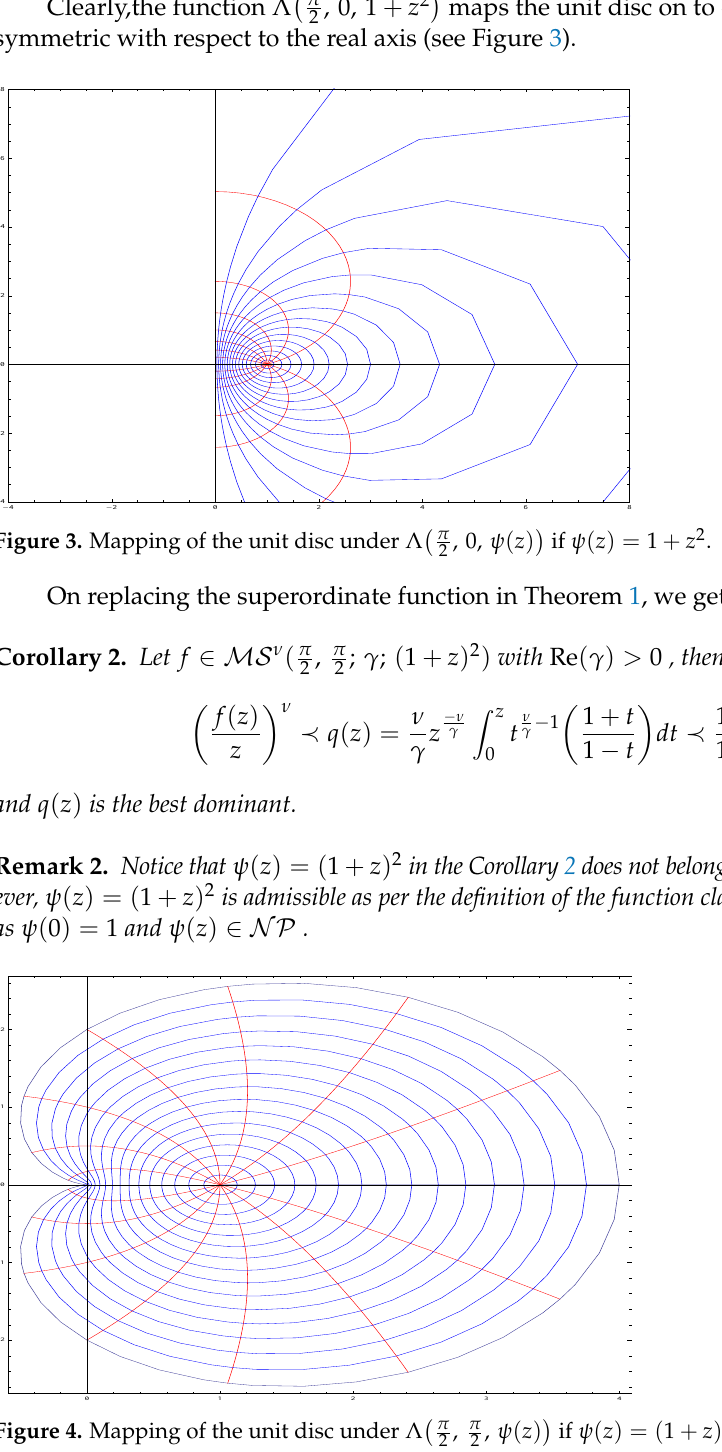
Figure 4. Mapping of the unit disc under Λ